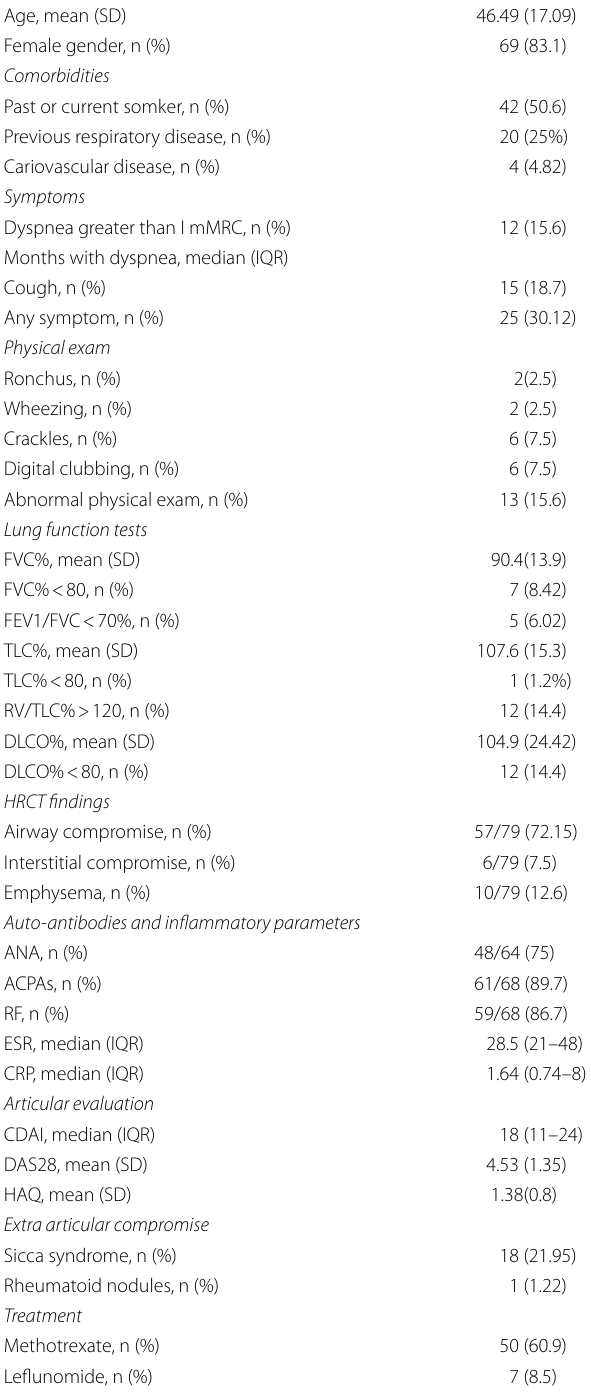
Table 1 General characteristics of the population of patients with early RA without known related pulmonary